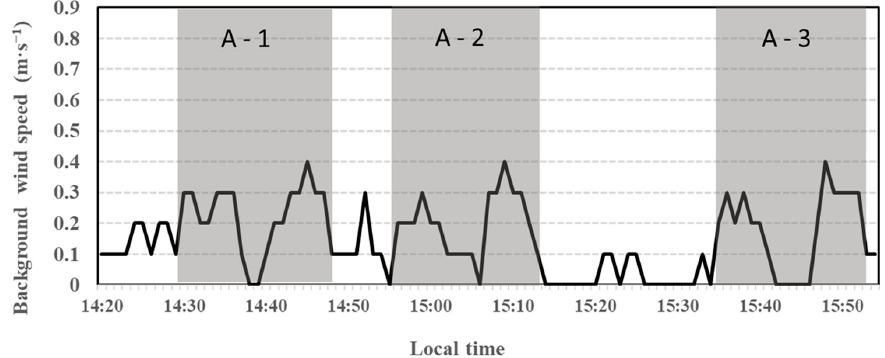
Figure 5. Time series of background wind speed measured with WXT510 during indoor analysis. The shaded sections correspond to the flight times for each run.